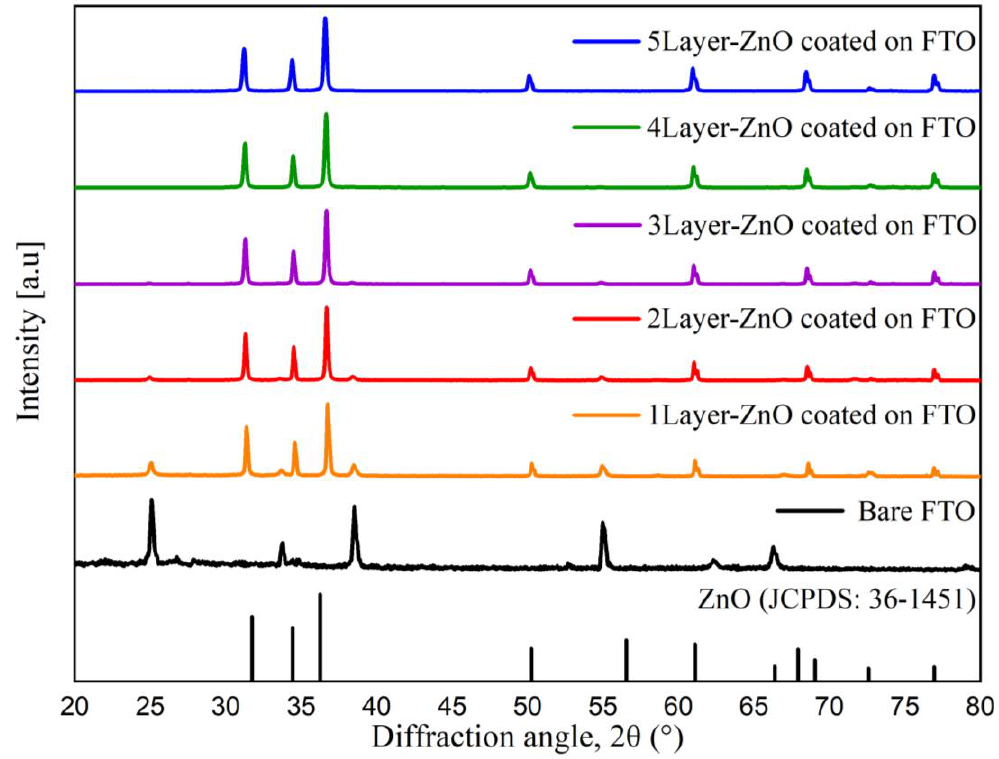
Figure 3. XRD graph of ZnO photoanode with different film layers.